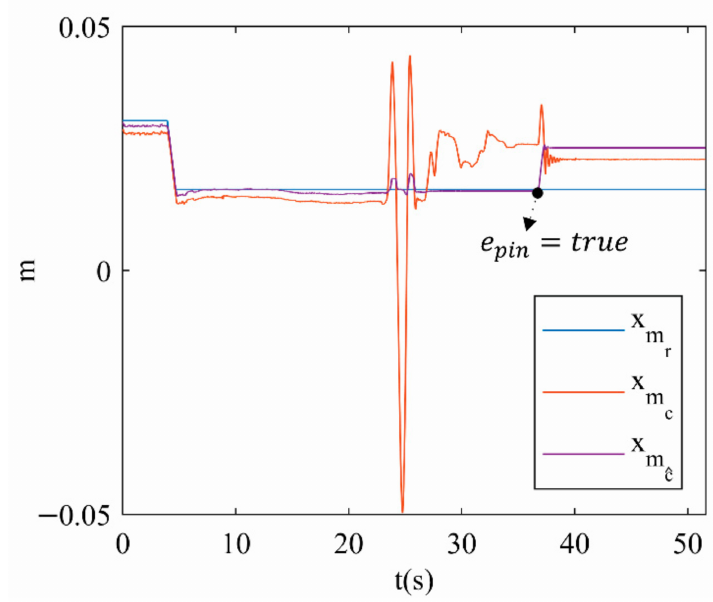
Figure 12. x m position for trajectory 1.